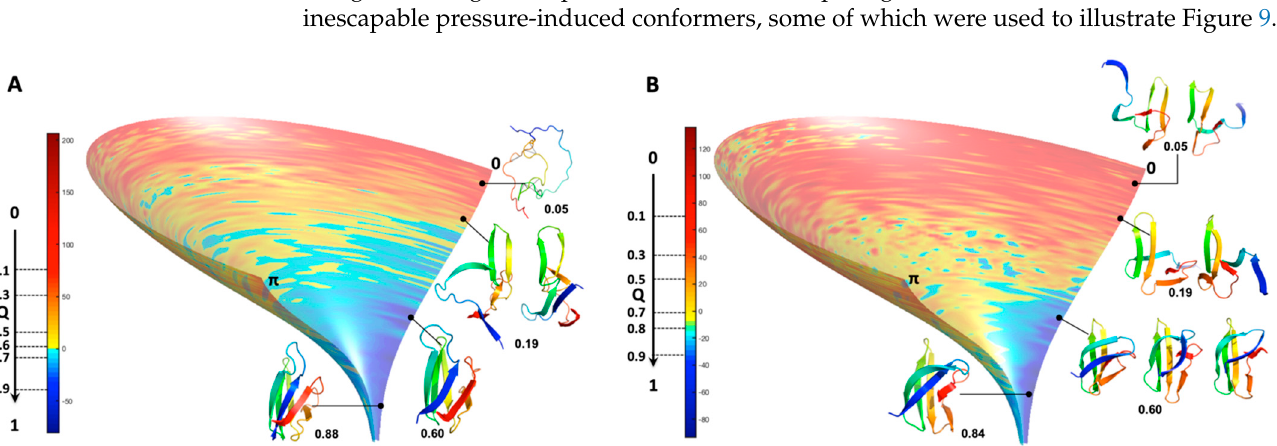
Figure 9. Folding funnels computed for AVR-Pia and AVR-Pib. Two identical idealized funnel-like surfaces were computed and the EvoEF2 energy values were projected on these surfaces for ( A ) AVR-Pia and ( B ) AVR-Pib. The equivalence between the EvoEF2 energy (given by the color ramp from blue to red) and the Q axis (from 1 to 0) was taken from the MP clusters average energies (Figure 6C). Cartoon representations at the given Q values are shown for selected intermediate conformers corresponding to most of the fractional contact maps given in Figure 8. For AVR-Pia at Q = 0.05 C α -C α contacts are shown by black doted lines in a mostly unfolded structure.